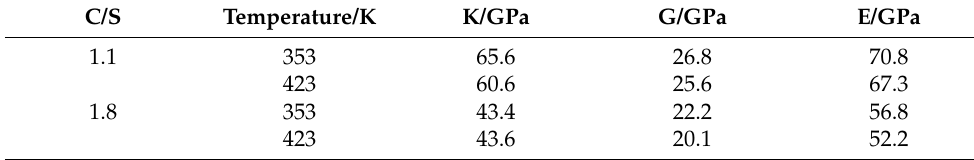
Table 4. Bulk, shear, and Young’s moduli under different temperature and C/S ratios.